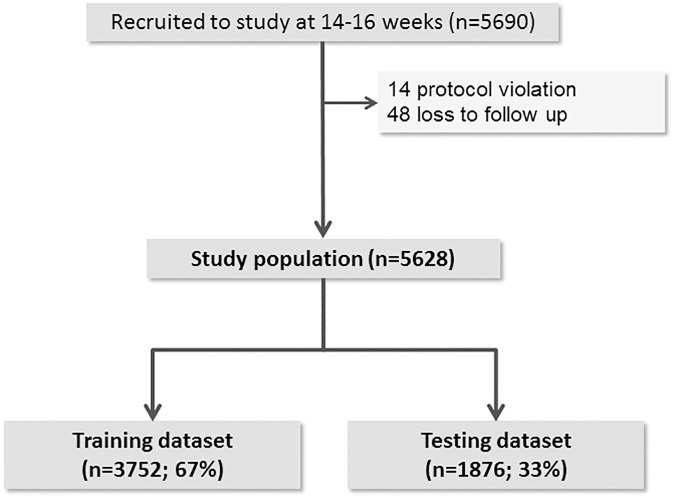
Study population.